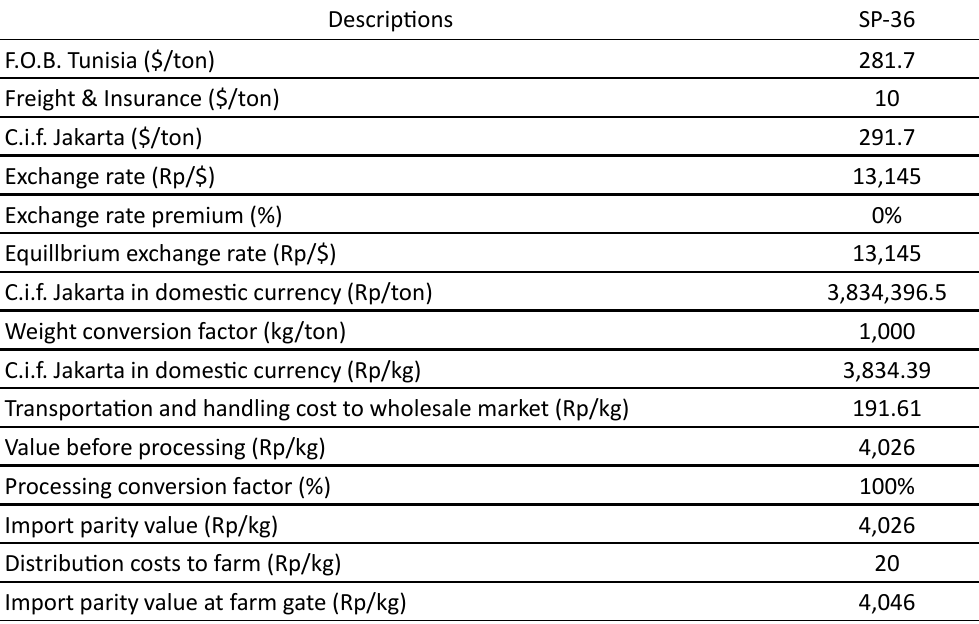
Table 5: Import Parity Price for SP-36 Fertilizer Descriptions